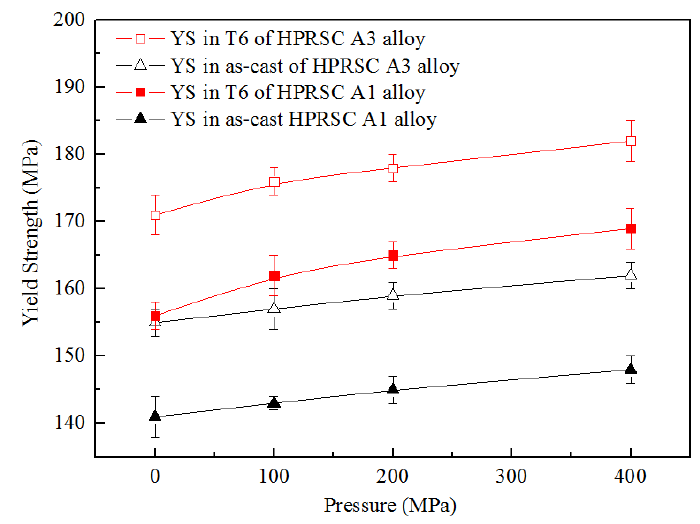
Figure 16. Yield strength (YS) of HPRSC A1 and A3 alloys with UV-ES compound field treatment.